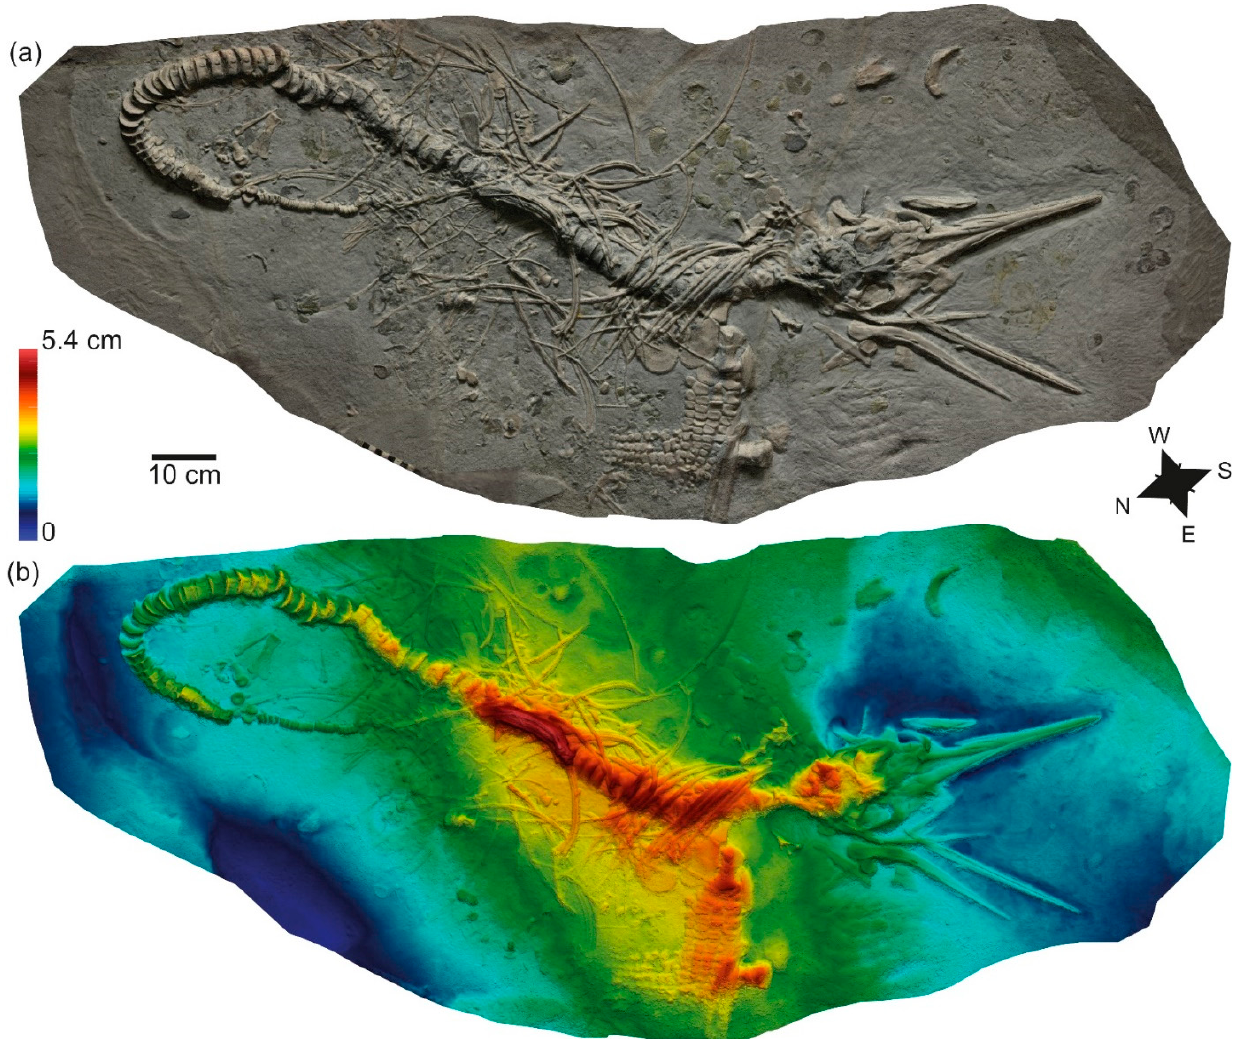
Figure 4. SMNS 81841, Stenopterygius quadriscissus , with preparation from below inferred. ( a ) Orthophoto; ( b ) false-color depth map showing relative topography of the specimen. Warmer colors (reds) indicate deeper penetration of the bones into the sediment; cooler colors (blues) indicate elements closer to the sediment surface.